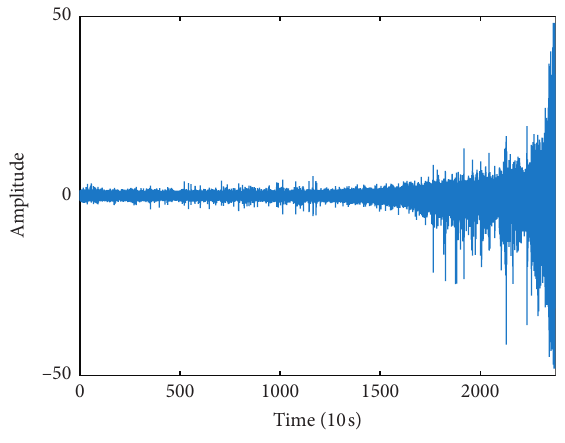
Figure 10: Vibration signal of bearing 1_3.